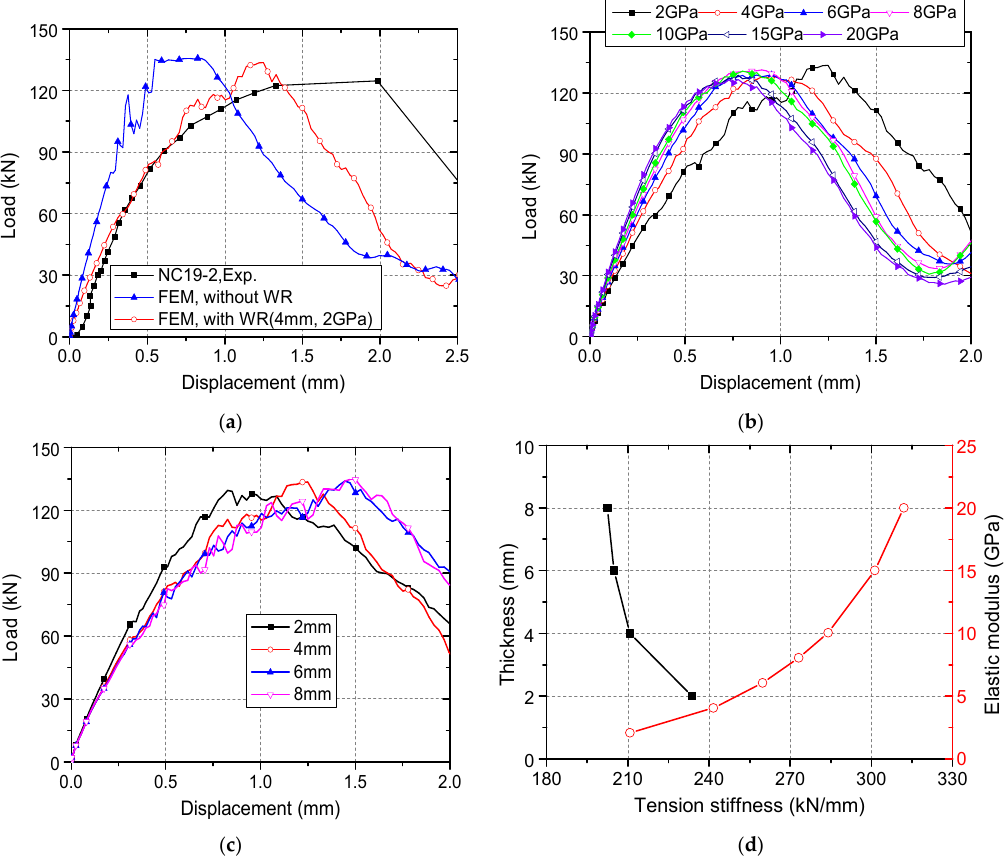
Figure 11. Effect of WR on the calculated results: ( a ) Calculated load–displacement curves of models with or without WR; ( b ) Results of models with different WR elastic moduli; ( c ) Results of models with different WR elastic thicknesses; ( d ) Effect of WR on tensile stiffness of connectors.